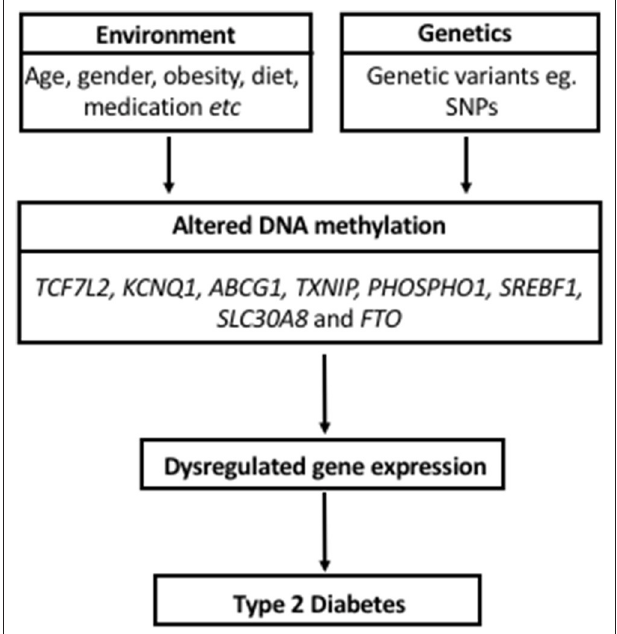
FIGURE 1 | Model proposing a role for DNA methylation in the pathogenesis of Type 2 Diabetes and its interaction with environmental factors and genetics.